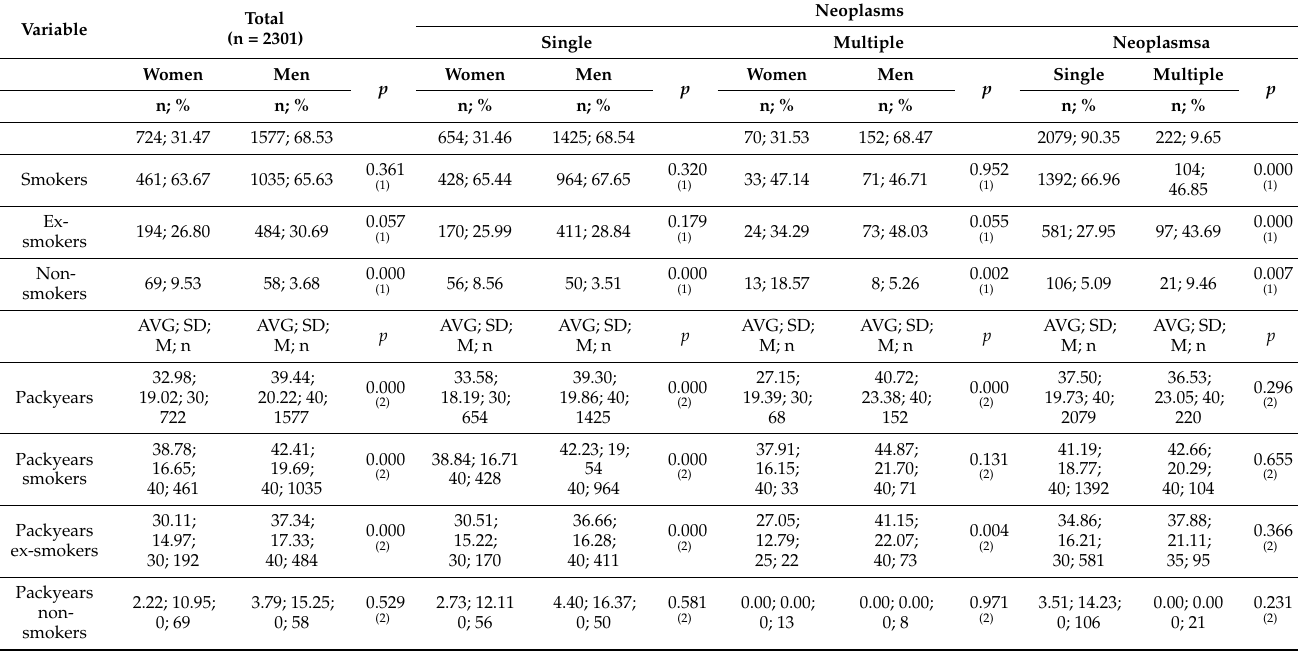
Table 1. Tobacco intake and packyears statistics based on gender and/or quantity of